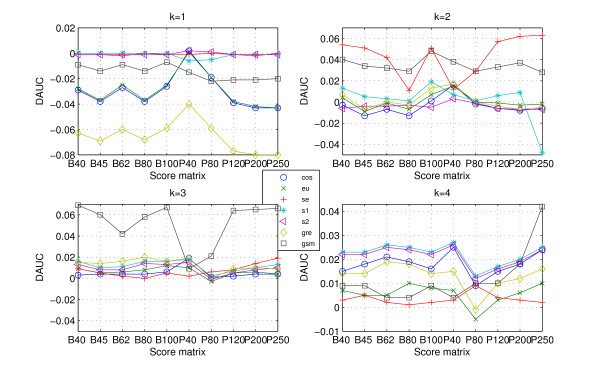
DAUC values for data SP. The DAUC values of seven statistical measures for data SP. All statistical measures based on k-word frequencies of protein 'sequence space' run with k from 1 to 4, where protein 'sequence space' is constructed according to ten score matrices. One graph presents each word length (from 1 to 4).